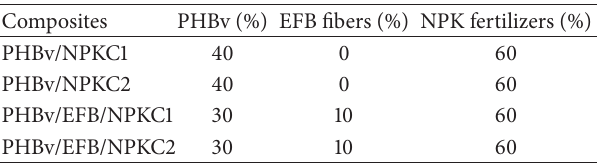
Table 1: Formulation of bioplastic fertilizer (BpF) composites